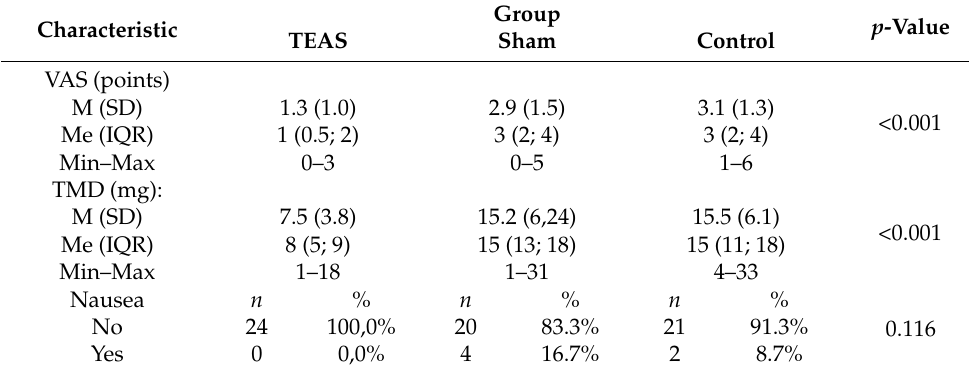
Table 2. VAS pain sensation and total morphine dose